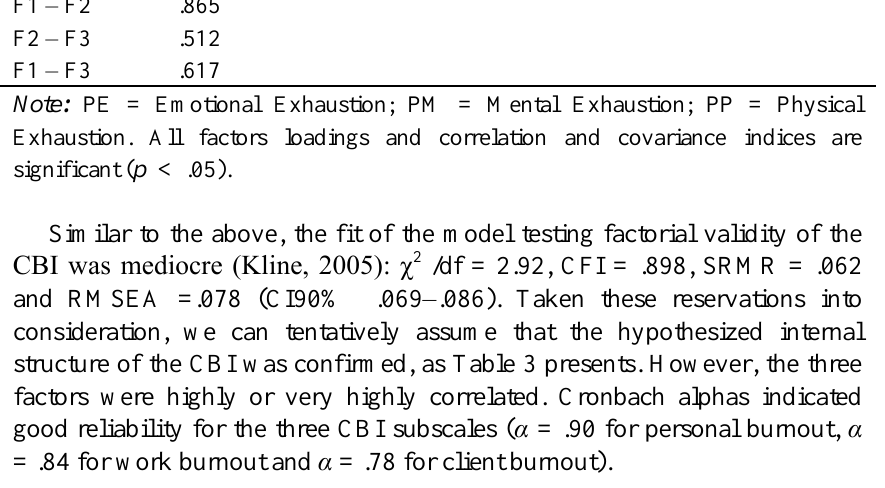
The structure of the Copenhagen Burnout Inventory (standardized